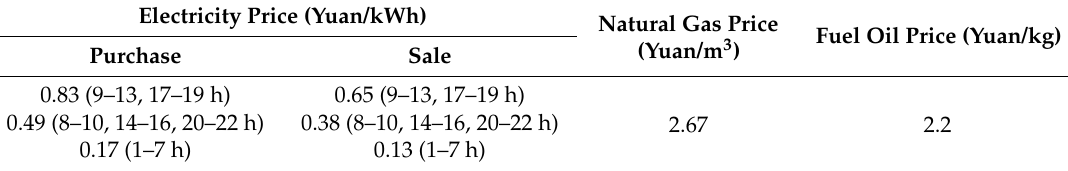
Table A2. Energy